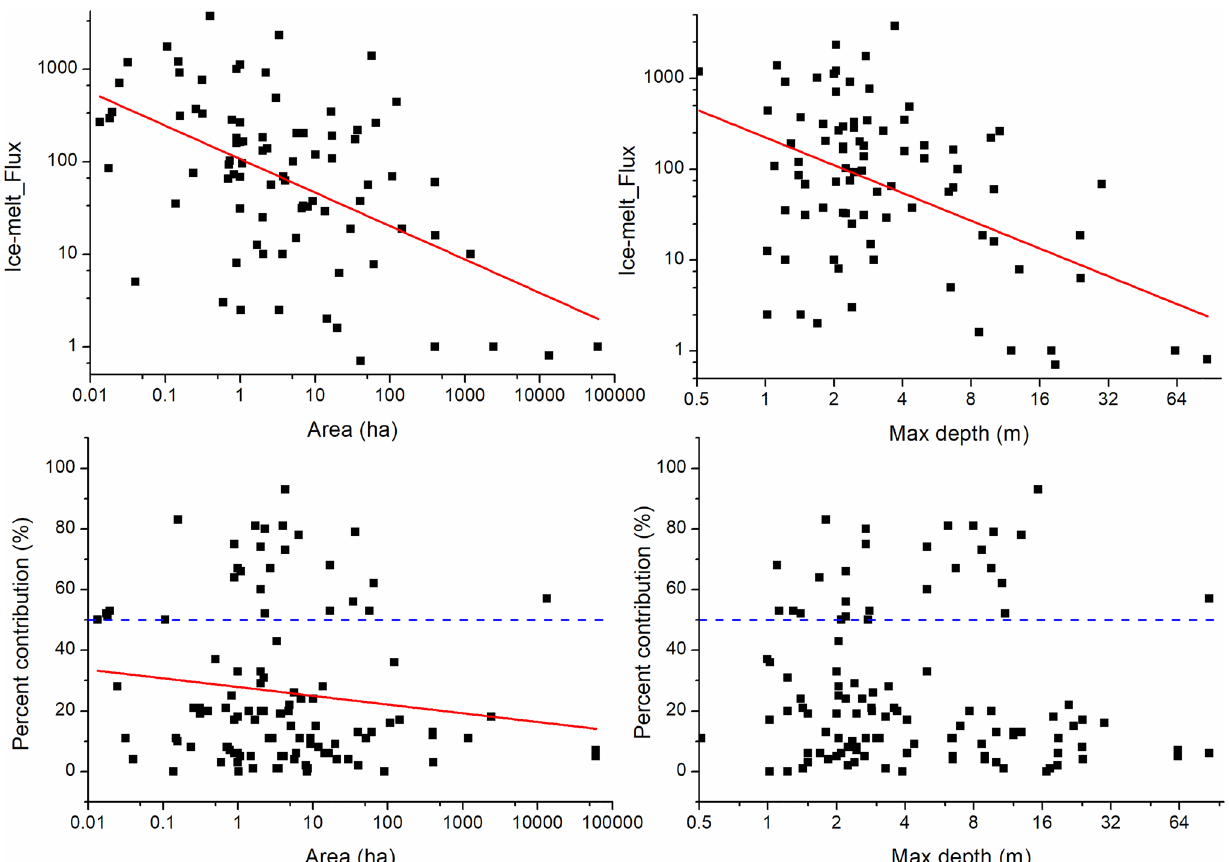
Fig. 3 Ice-melt CH emission flux (mmol m −2 ) and the percentage contribution in relation to lake area and maximum depth. Red lines are 4 linear fits of all data; blue dash lines equal to 50% contribution. Note logarithmic